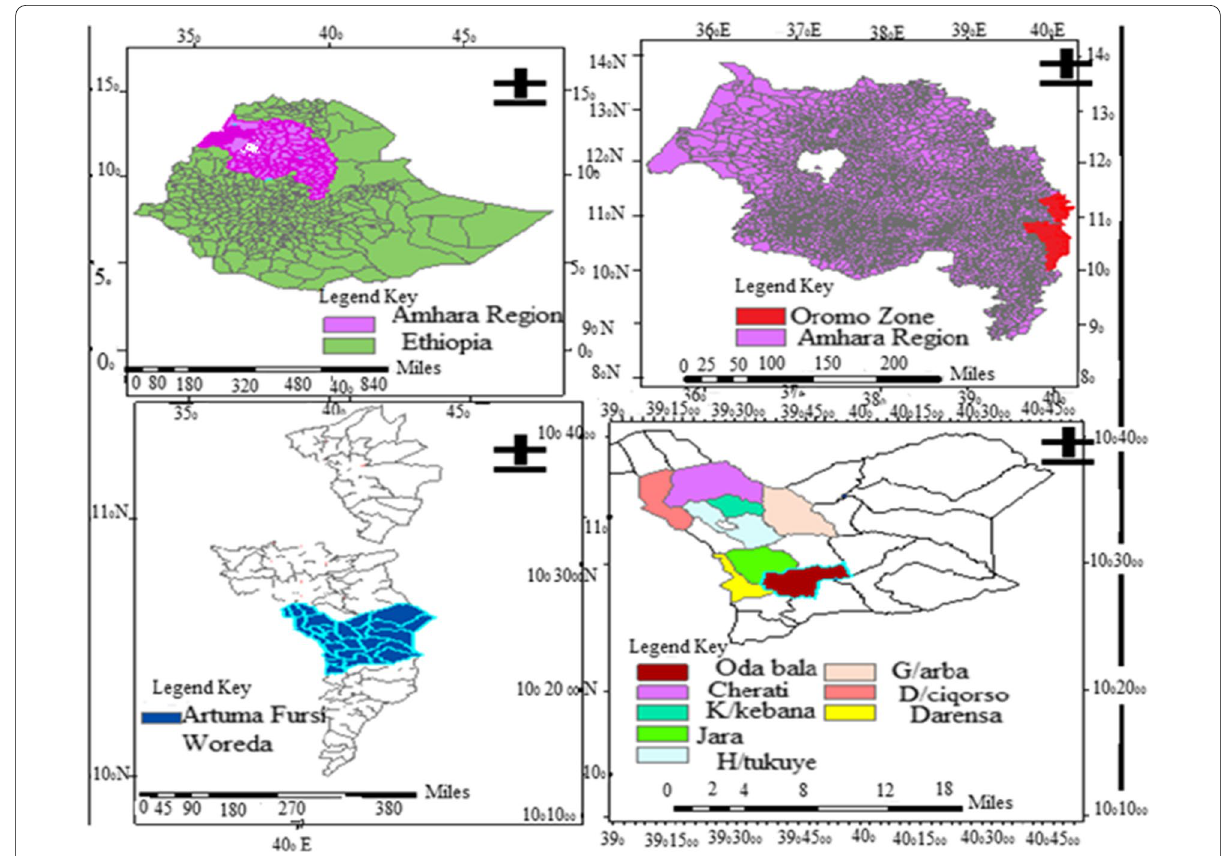
Fig. 1 Location of the study area in Artuma Fursi